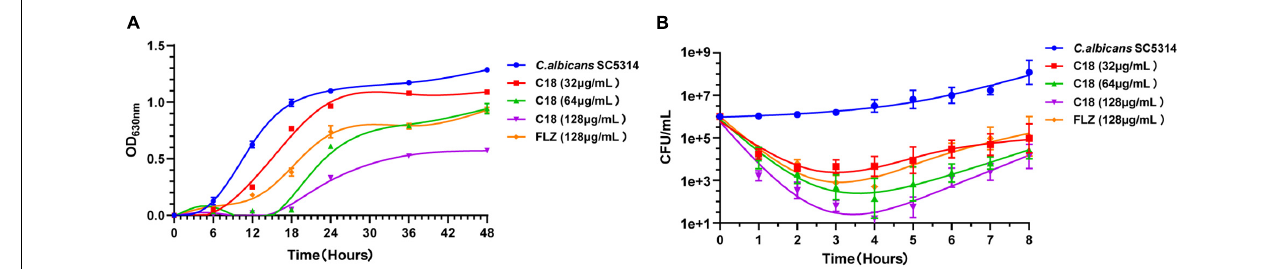
FIGURE 2 | Inhibition and killing kinetics of C18 against Candida albicans . (A) Growth curve of C. albicans within incubation for 48 h. Optical density at 630 nm (OD 630nm ) of C. albicans SC5314 in the presence or absence of C18 at the concentration of 32 ∼ 128 µ g/ml was measured. (B) Time-killing kinetics of C18 against C. albicans SC5314. Fungal cells were incubated with C18 at concentrations of 32 ∼ 128 µ g/ml for 8 h, and the colonies of C. albicans suspension were counted at every 2 h. The drug-free strain-containing medium was set as the control and fluconazole (FLZ) was used as the positive drug. Each data point represents mean ± SD of three independent